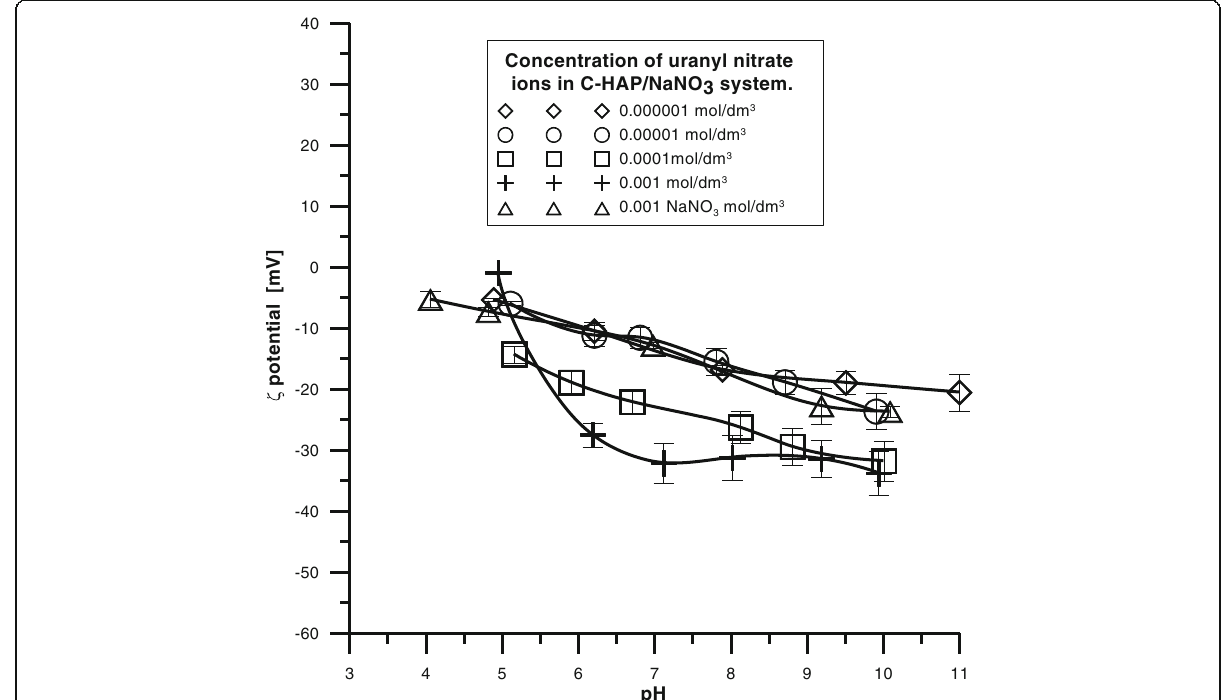
Fig. 11 The zeta potential as a function of pH for C-HAP dispersed in NaNO 3 solution with different concentrations of U(VI)